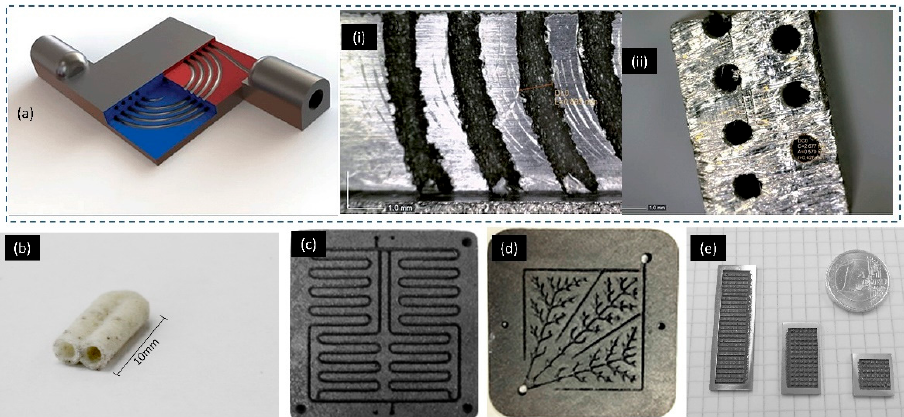
Figure 8. Example of various powder-based 3D-printed fluidic applications. ( a ) SLM 3D-printed